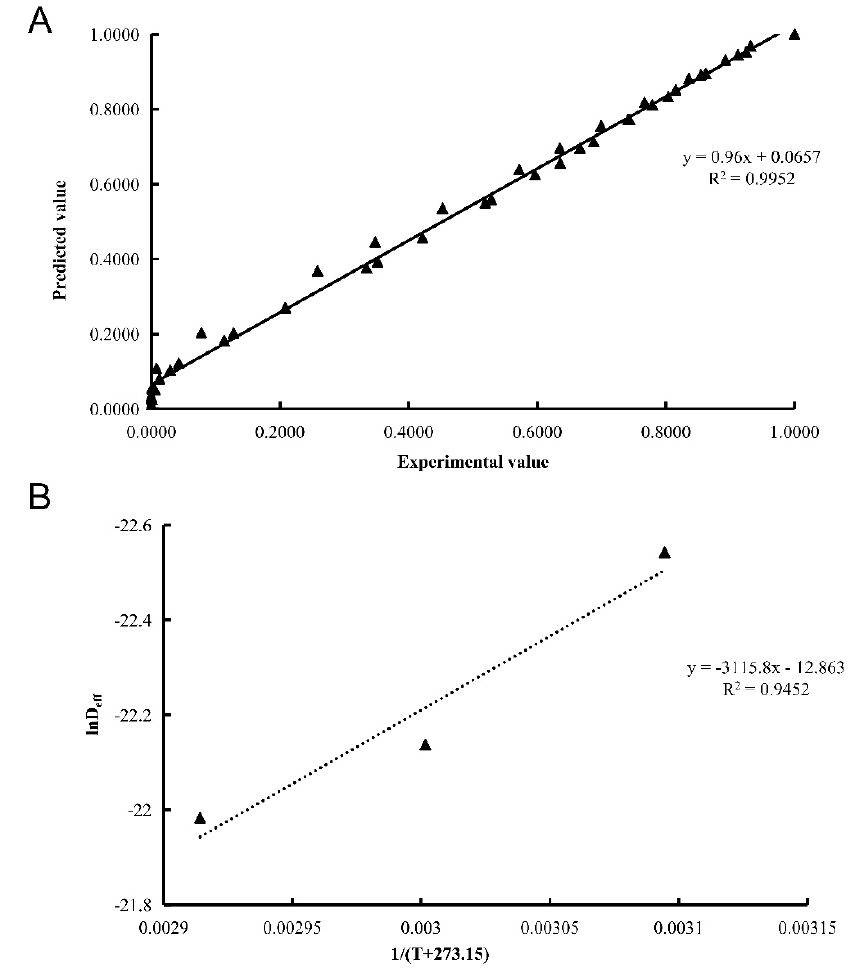
Figure 2. Comparison between experimental MR and predicted MR values of the Page model at different conditions ( A ). Arrhenius-type relationship between D eff and temperature ( B ). different conditions ( A ). Arrhenius-type relationship between D